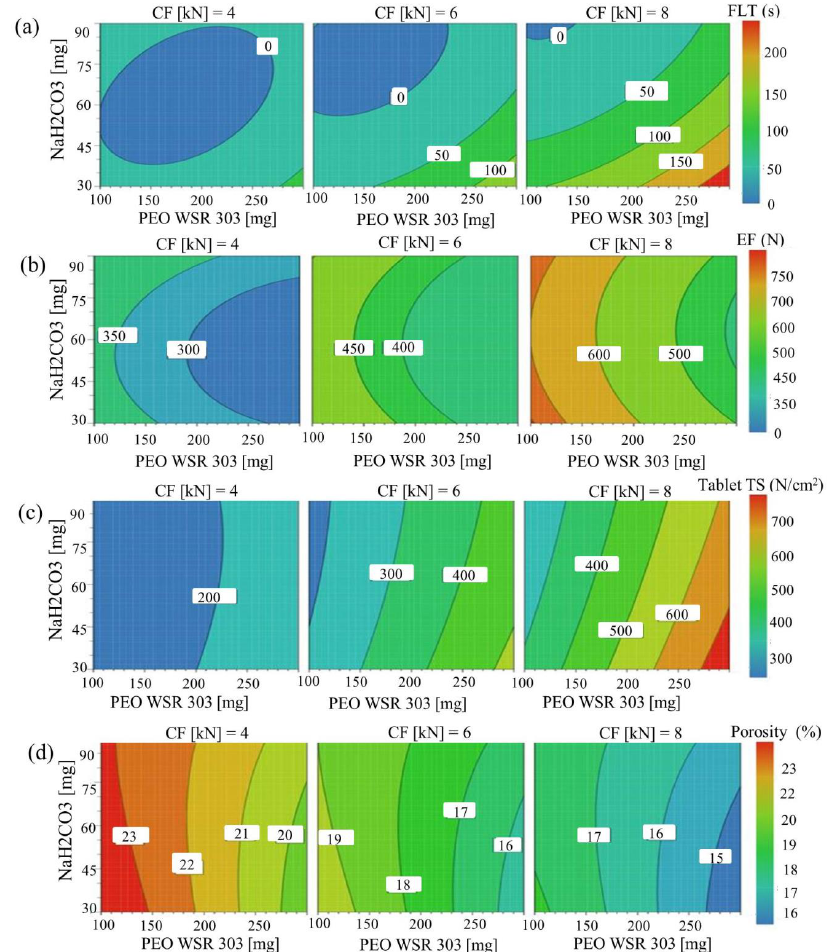
Figure 8. Figure 8. Contour plots showing the effects of hydrophilic polymer (PEO) and sodium bicarbonate on ( a ) floating lag time, ( Y 4 ), ( b ) tablet ejection force, ( Y 5 ), ( c ) tablet tensile strength, ( Y 6 ), and ( d ) tablet porosity ( Y 7